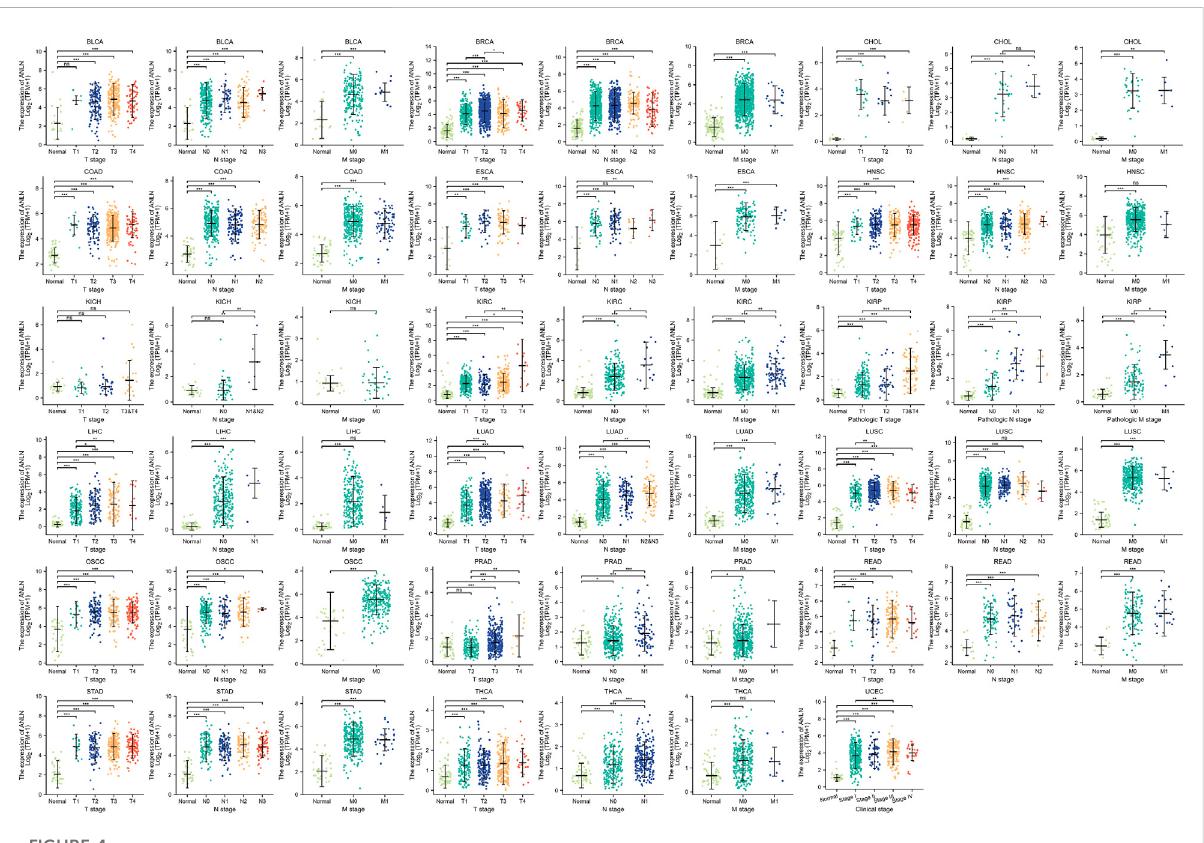
FIGURE 4 Association between ANLN expression and tumor stages (T, N, M, and clinical stages). * p < 0.05, ** p < 0.01, *** p < 0.001. Ns, not statistically signi fi